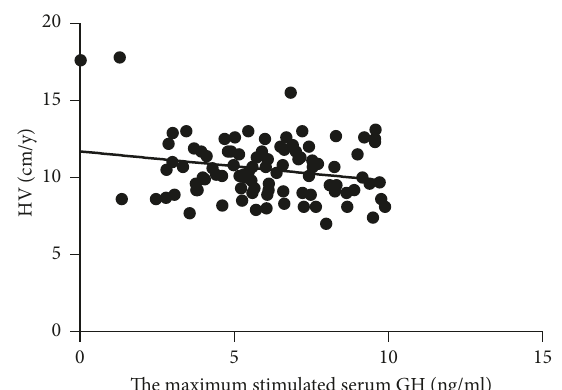
Figure 3: Relationship of 12-month HV to the maximum stim- ulated serum GH in patients with GHD ( r � − 0.19, p � 0 . 0368).